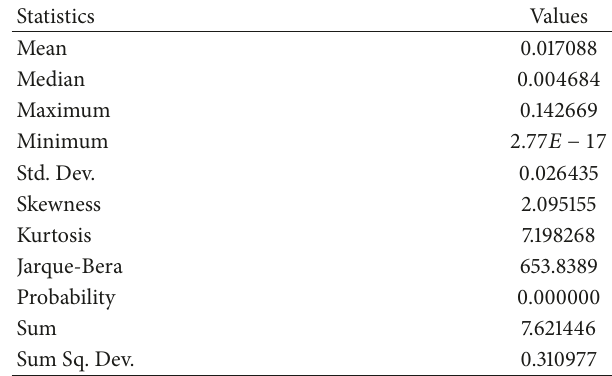
Table 5: Extreme risk fear statistics in 2012-2013.